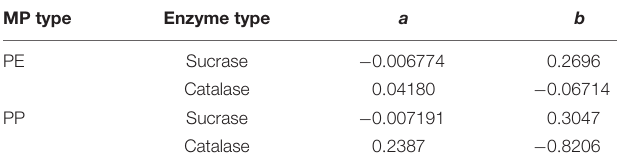
TABLE 3 | Polyethylene (PE) and polypropylene (PP) mass in this